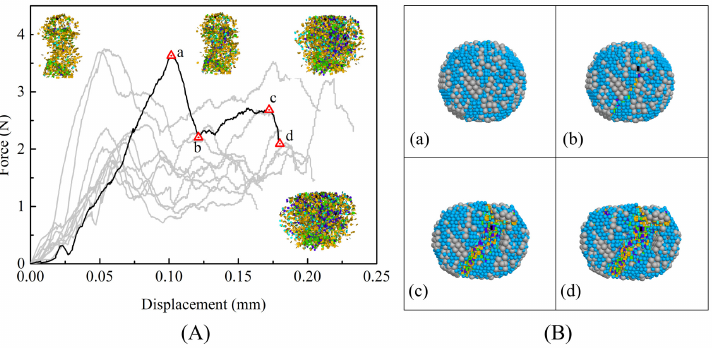
7 Figure 7. DEM results of single particle crushing tests for a spherical particle: ( A ) force–displacement curves and spatial distribution of different microcracks; ( B ) particle states of the loading process. ( a ) elastic limit; ( b ) yield minimum; ( c ) breakage peak; ( d ) finial failure.